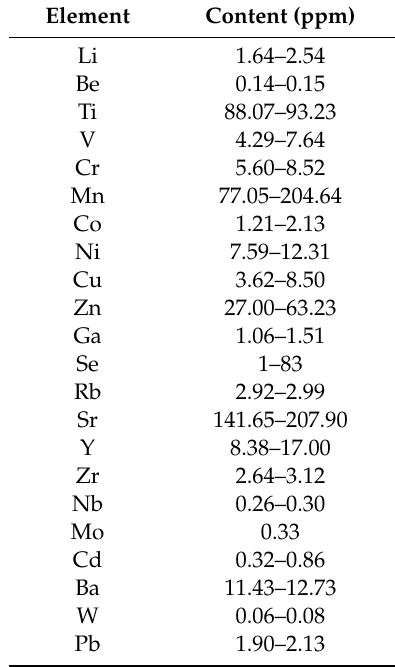
Table 1. Elemental Content of the Studied